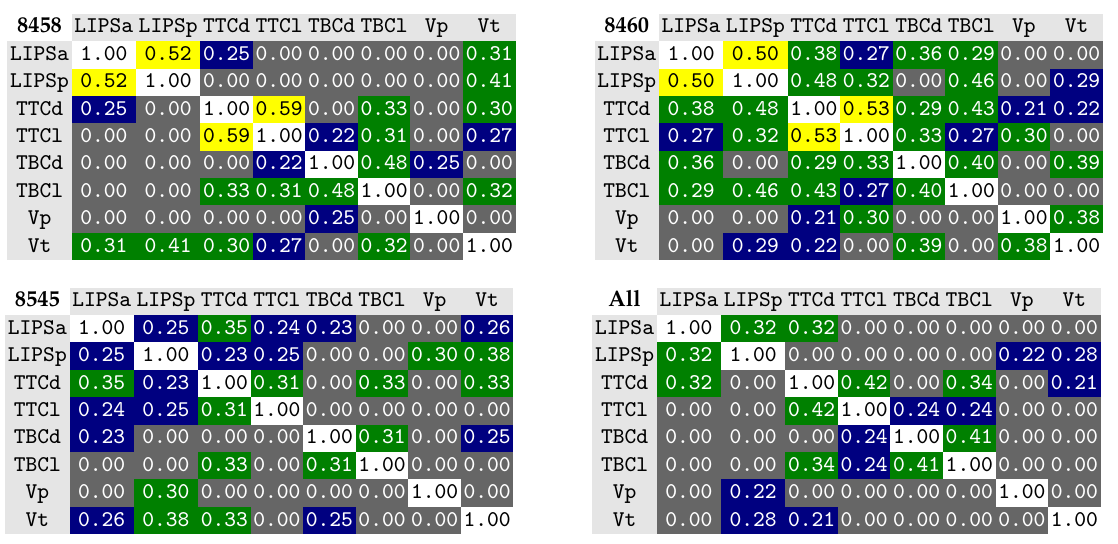
Figure 6. Correlation among the different components of the considered tract variables (1D correlation) for the three speakers 8458, 8460 and 8545, and for the speaker gathering the normalized data. Tract variables for 1D correlation: LIPSa : lip aperture; LIPSp : lip protrusion; TTCd : tongue tip constriction distance; TTCl : tongue tip constriction location; TBCd : tongue body constriction distance; TBCl : tongue body constriction location; Vp : velar port distance; Vt : orovelar port distance. Table 3. Canonical correlation for pairs of the chosen tract variables (2D canonical correlation) for the three speakers (8458, 8460, and 8545) and for the speaker gathering the normalized data.